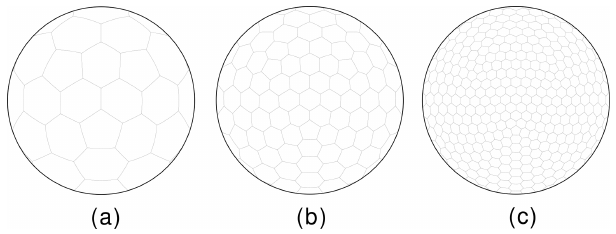
Figure 1. SCVT grids using a uniform density function for 12 (a) , 42 (b) and 162 (c)